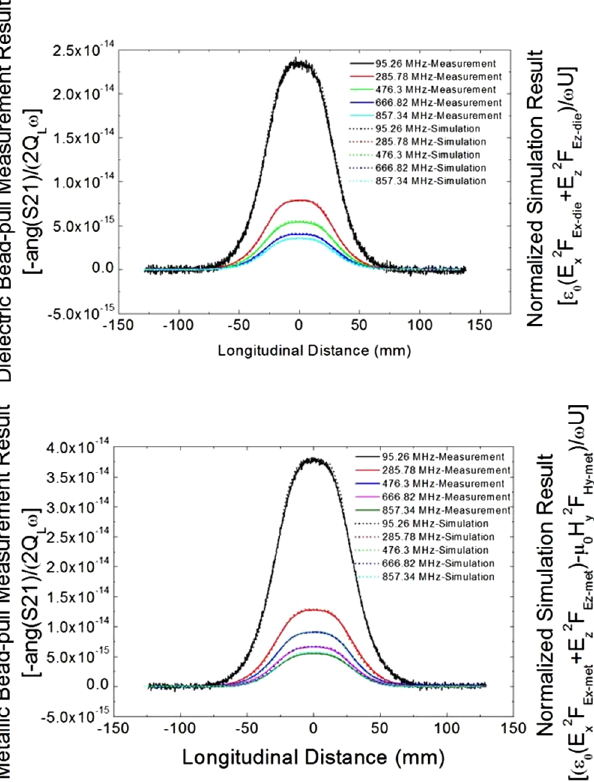
FIG. 19. Pillbox cavity used for calibration of the perturbing